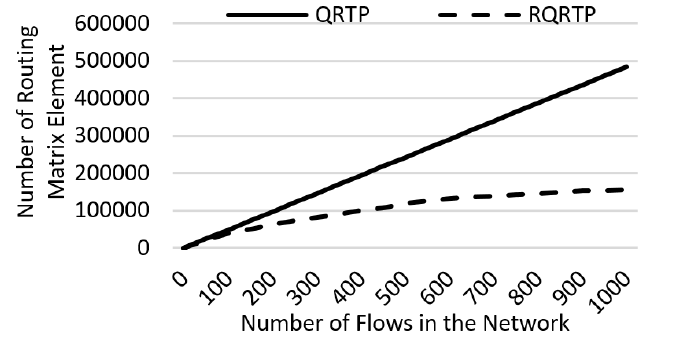
Figure 8. Comparison of QRTP (QoS-aware resource reallocation traffic prediction) and relaxed QRTP (RQRTP) based on the number of routing matrix element. Increasing the number of active flows in the network makes the superiority of RQRTP more clear. This happens because RQRTP exploits flow aggregation technique to reduce the number of routing matrix elements.